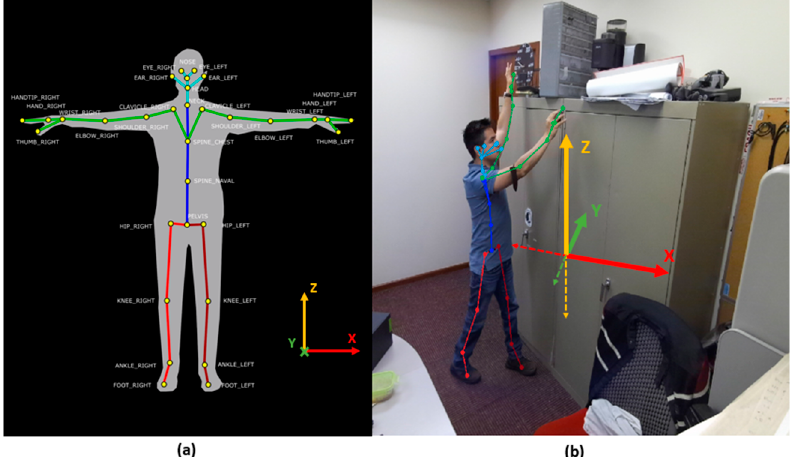
Figure 4. ( a ) Skeleton model joints; ( b ) skeleton model detected over the RGB image with its 3D coordinate reference.